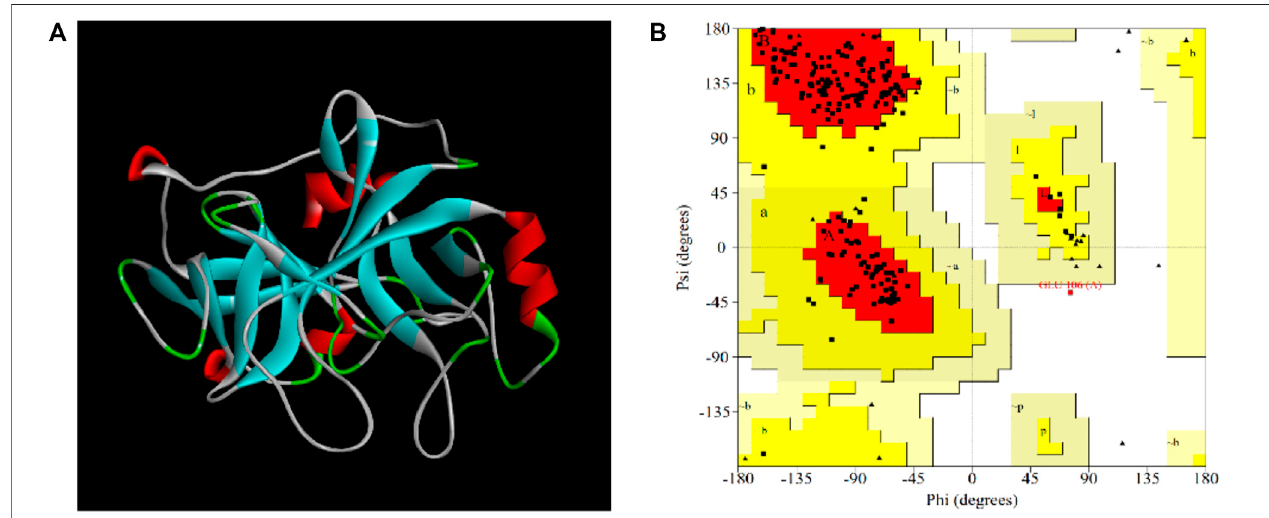
FIGURE 7 | The visual crystal structure (A) and Ramachandran plot (B) of EPF3 structure model. Residues present in favored, additional allowed, generously allowed, and disallowed regions were shown with red, luminous yellow, green, and white color demarcation, respectively.